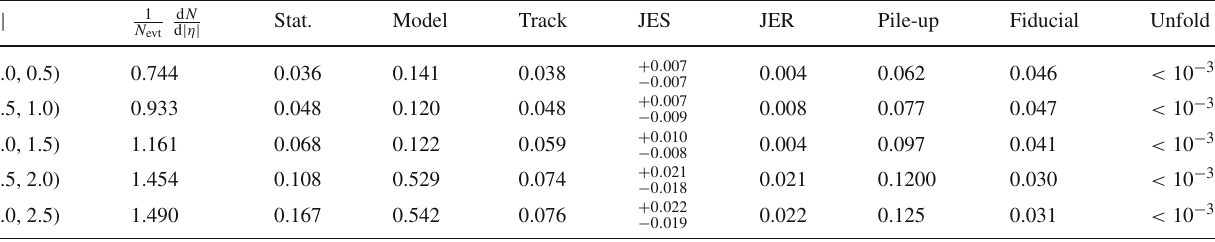
not associated with jets, and including invisible decays, along with the S